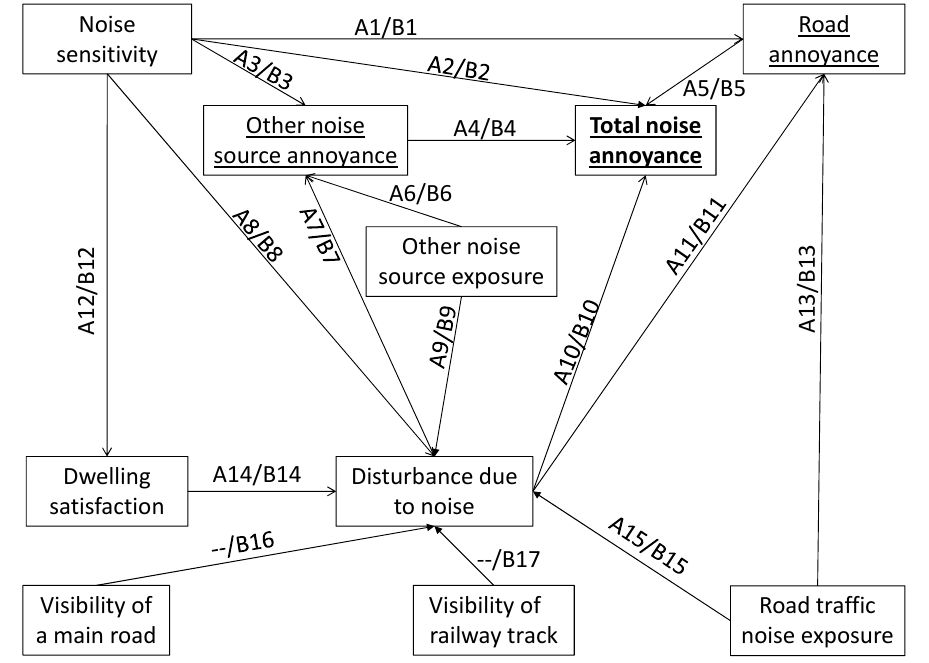
Figure 3. Perceptual structural equation model of total noise annoyance without and with Visibility of noise source. A1 to A15 represent the standardized coefficients in Model per-A, whereas B1 to B17 represent the standardized coefficients in Model